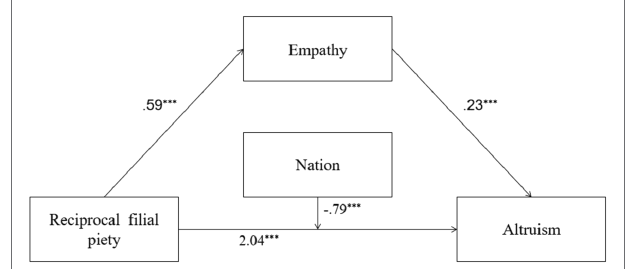
FIGURE 3 | Mediation and moderation model showing standardized coefficients (Model 3); *** p < 0.001.